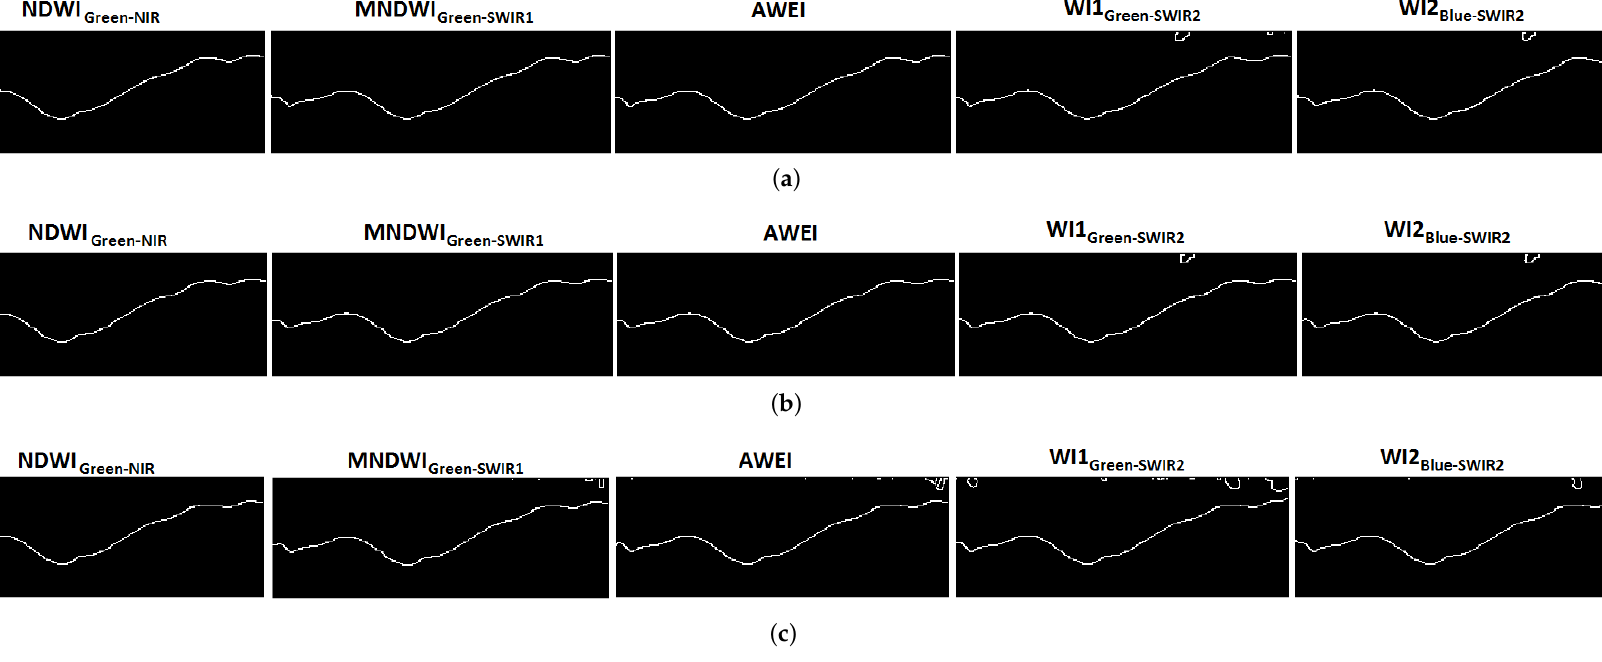
Figure 11. Shorelines extracted from TM, ETM+, and OLI images in the Adra River Delta. ( a ) The shoreline detected on a TM image recorded on 9 October 2011. ( b ) The shoreline detected on an ETM+ image recorded on 6 September 2002. ( c ) The shoreline detected on an OLI image recorded on 20 December